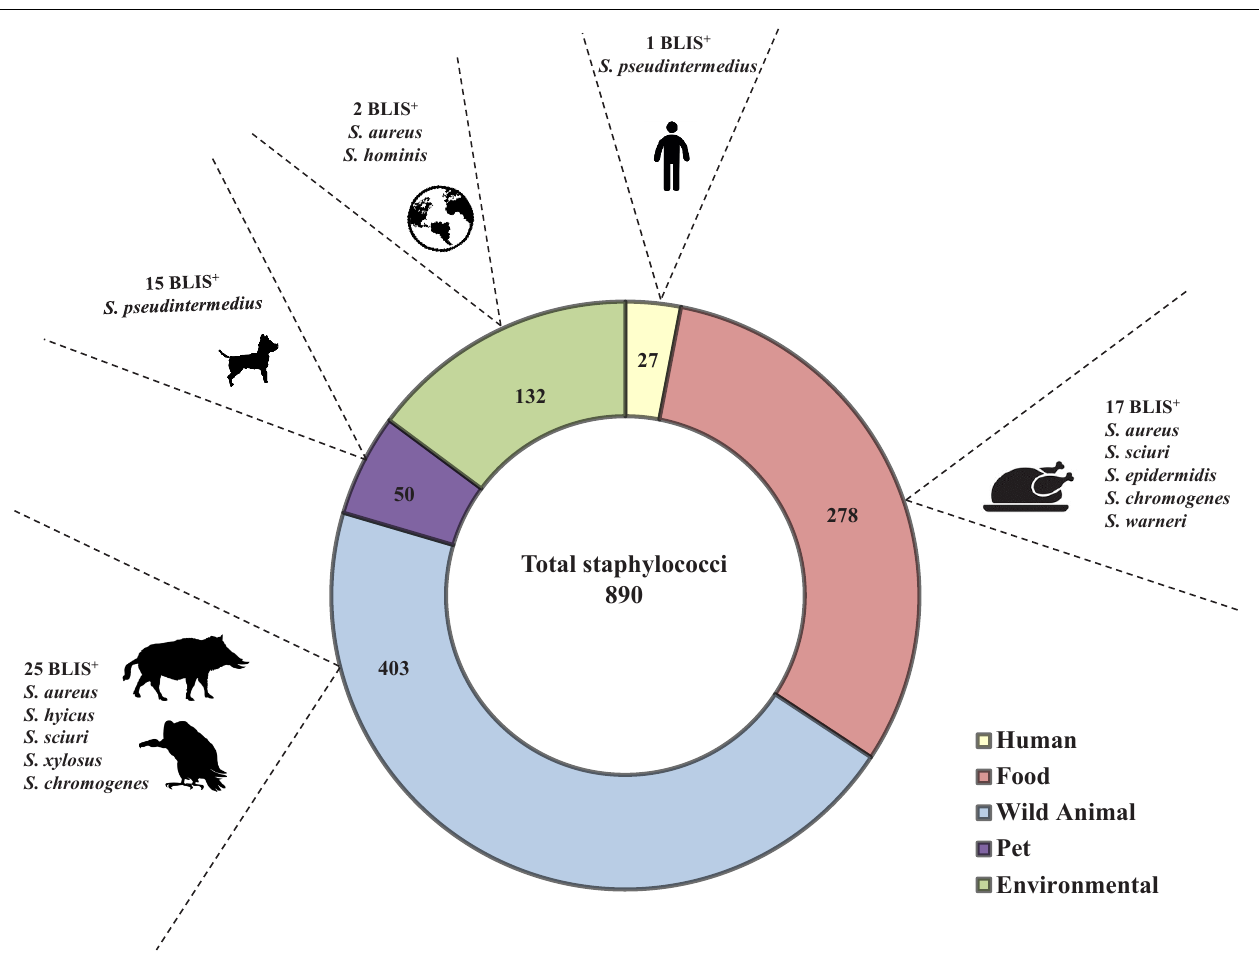
FIGURE 1 | Distribution of the 60 BLIS + isolates per origin, indicating the species and the number of isolates in which antimicrobial activity was